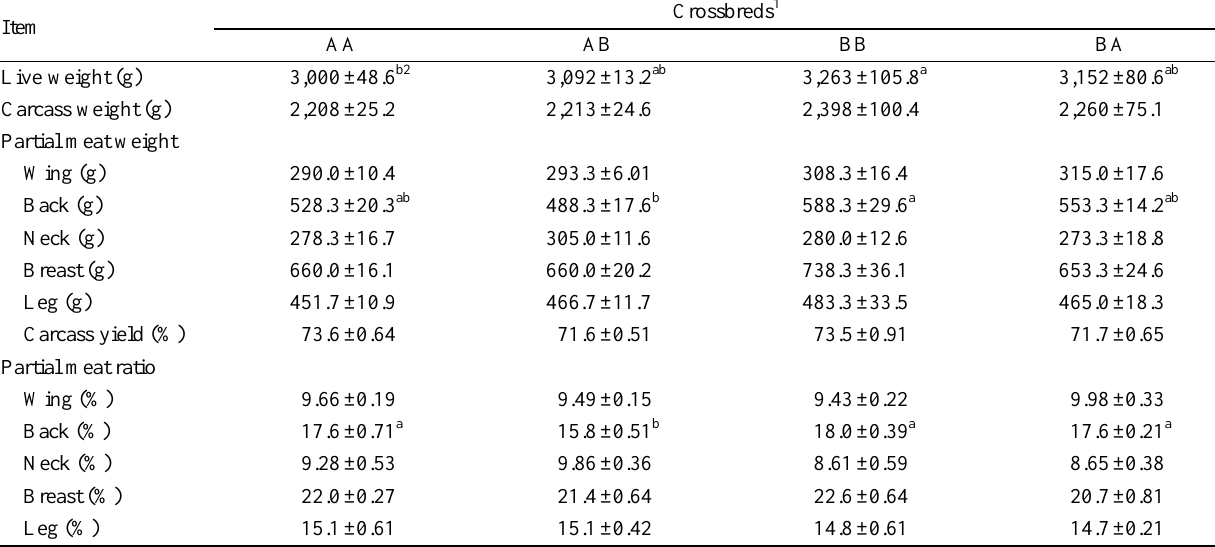
Table 6. Carcass yield and partial meat ratio of commercial Korean native ducks Item